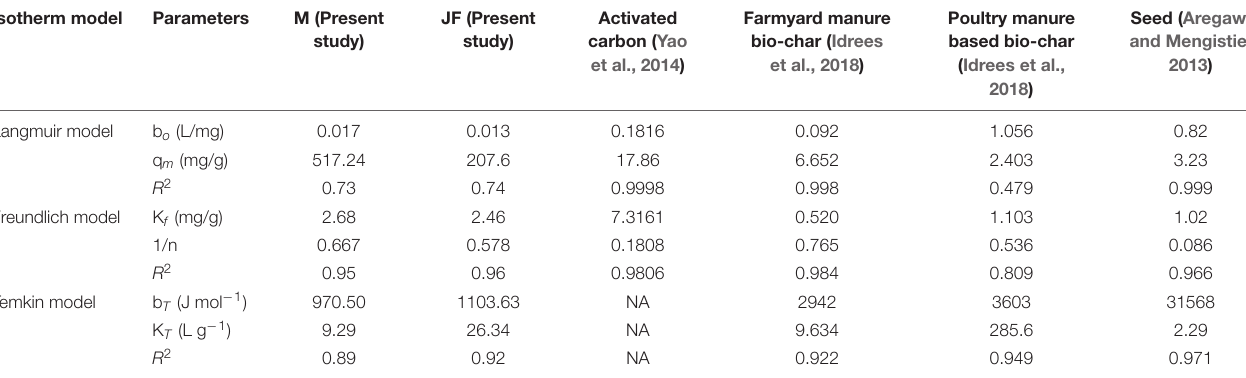
TABLE 3 | Summary of equilibrium parameters of Cr (VI) adsorption on Mango (M) and Jack fruit (JF) kernel biomass. Isotherm